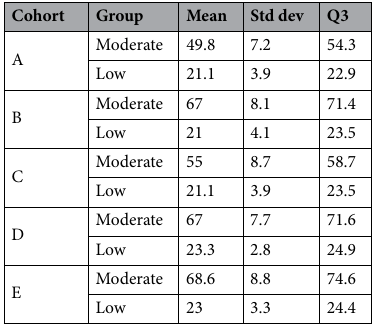
Table 2. Summary statistics for relative humidity exposures by experimental cohort. Cohorts A and B: RT-qPCR experiment; Cohort C: pilot proteomics experiment; Cohorts D and E: comprehensive proteomics experiment. Std dev standard deviation, Q3 third